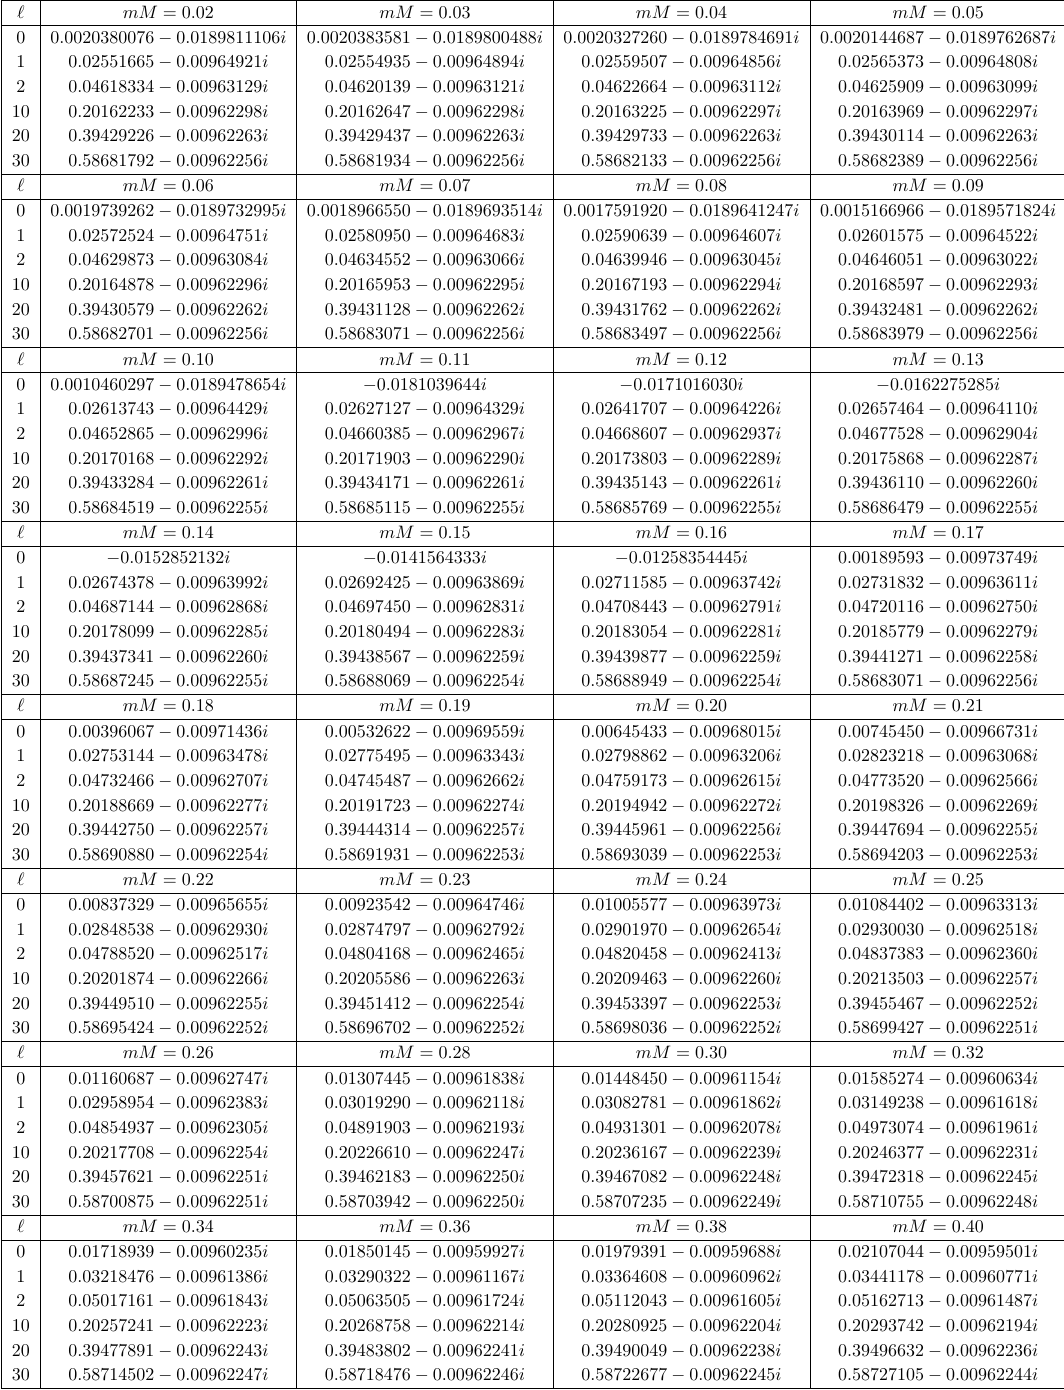
Table 6 . Fundamental quasinormal frequencies ( n = 0) for massive scalar (cid:12)elds with ‘ = 0 ; 1 ;